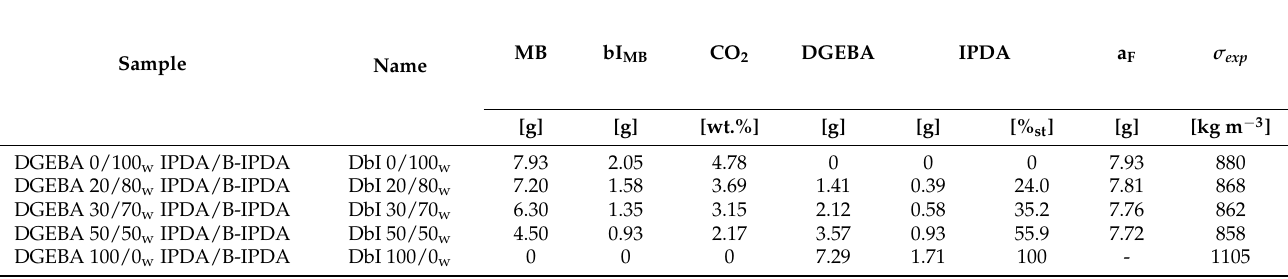
Table 1. Required amounts of materials for the different foaming mixtures referring to 9 g total foaming mixture. As B-IPDA is already included in the masterbatch (MB), only DGEBA and IPDA are added for dilution and stoichiometric curing. For completion, the amount of B-IPDA in the specific amount of MB (bI MB ) and its resulting CO 2 content, as well as the related stoichiometric percentage of IPDA, are also indicated. In addition, the expected density ( σ exp ) resulting from a filling amount of 75 % (a F ) is